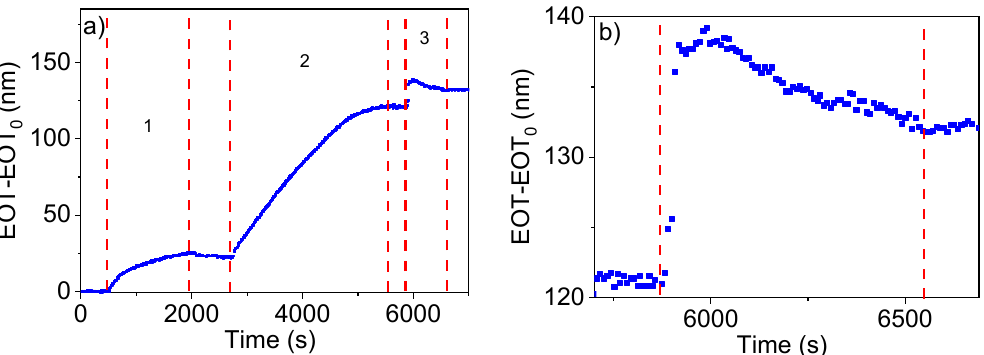
Figure 4. ( a ) Registered change in EOT as a function of time during NAA surface functionalization: (1) sulfo-NHS-biotin, (2) streptavidin, (3) trombin-binding-aptamer (TBA). ( b ) A close-up of the EOT variation with time of the step 3 of the experiment in Figure 4a.